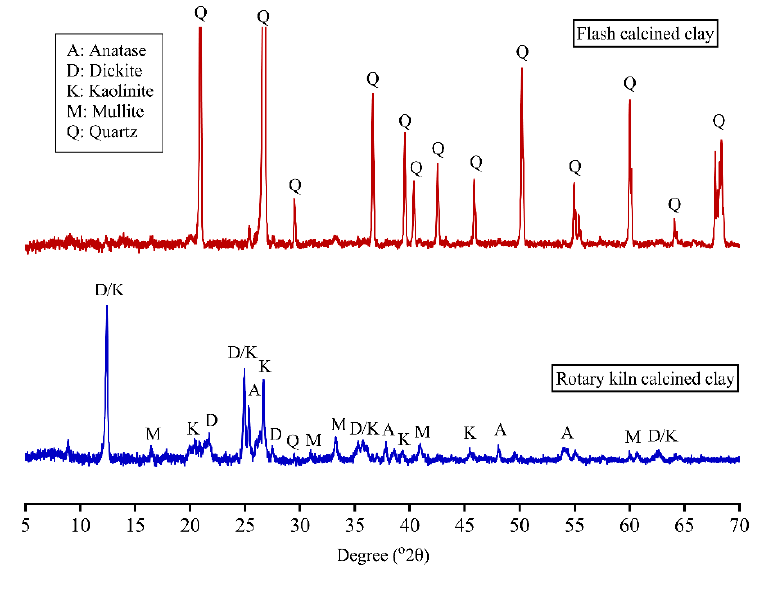
Figure 2. X-ray di ff raction (XRD) patterns of calcined clays. Figure 2. X-ray diffraction (XRD) patterns of calcined clays. Table 3. Mineral composition and specific surface area of calcined clays. Table 3. Mineral composition and specific surface area of calcined clays. Minerals